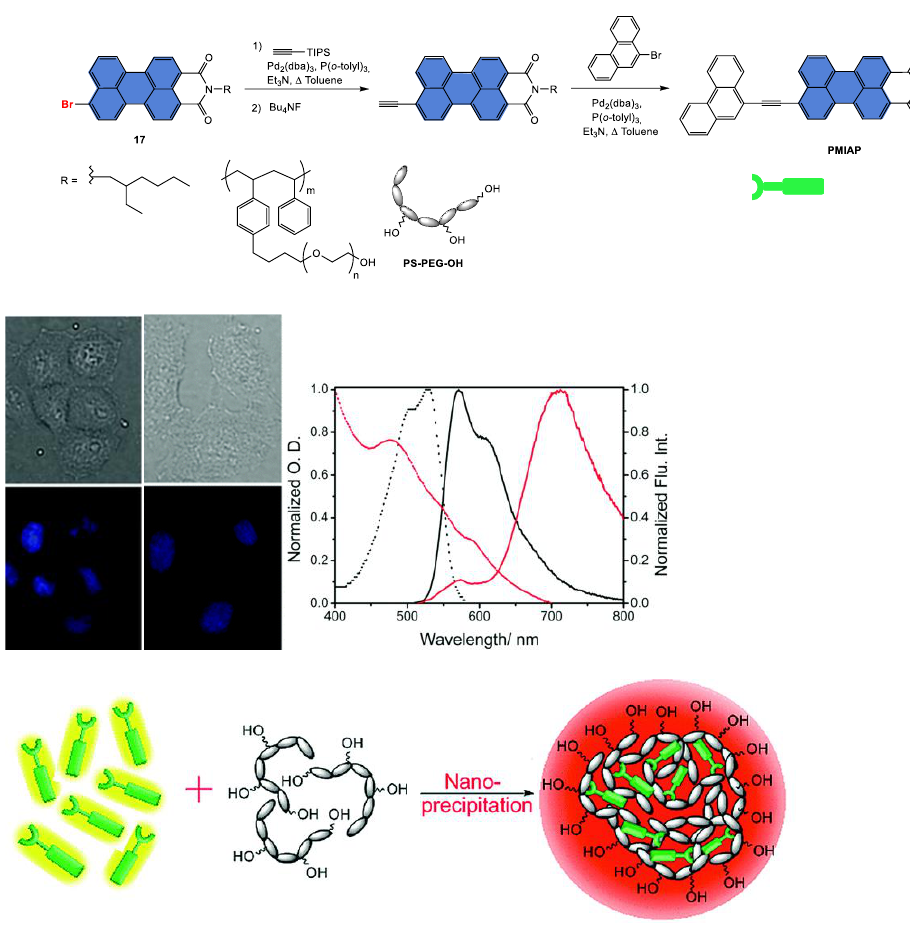
Figure 32. Synthetic scheme of PMIAP; UV-Visible absorption and emission spectra of PMIAP in THF (black) and upon doping inside the PNP (red); schematic representation of PMIAP-doped PNP via a nanoprecipitation method. Reprinted with permission from reference [146]. Copyright 2018 Royal Society of